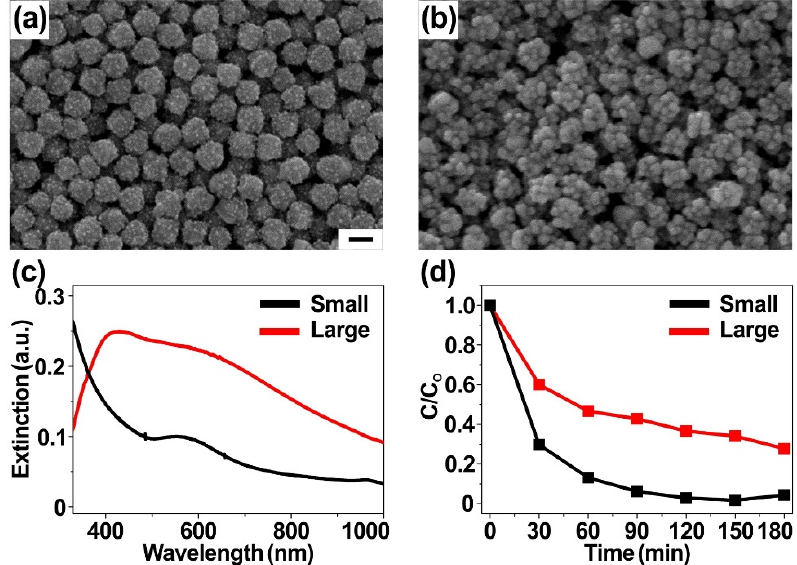
Figure 2. ( a–b ) SEM images of the AgCl@AgAu NPs with ( a ) small metallic bumps and ( b ) large metallic bumps which were grown from the ones in Figure 2a. The scale bar is 200 nm. ( c ) UV-vis spectra of the AgCl@AgAu NPs with small and large bumps. ( d ) Time-dependent photocatalytic degradation of amaranth with the AgCl@AgAu NPs with small and large bumps.